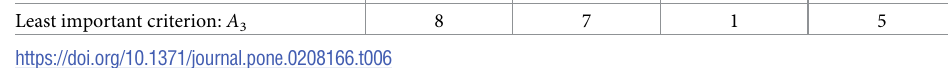
Table 5. The pairwise comparison vector of the most important criterion. Table 6. The pairwise comparison vector of the least important criterion. Criteria